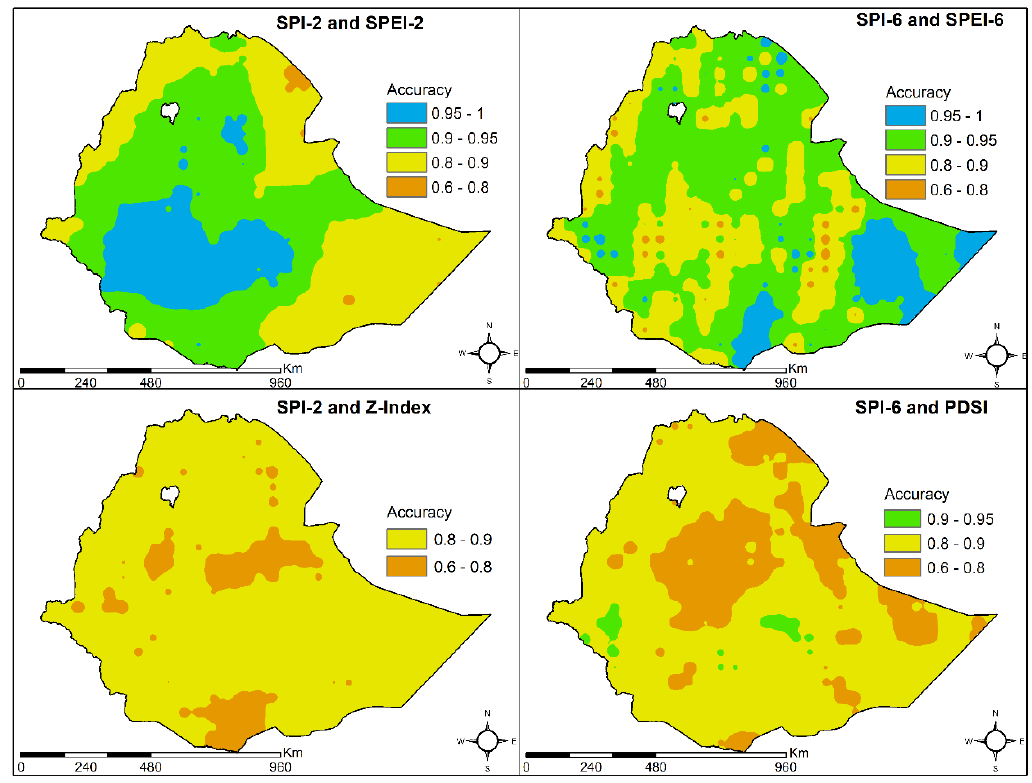
Figure 12. Accuracy measures of agricultural and meteorological droughts.